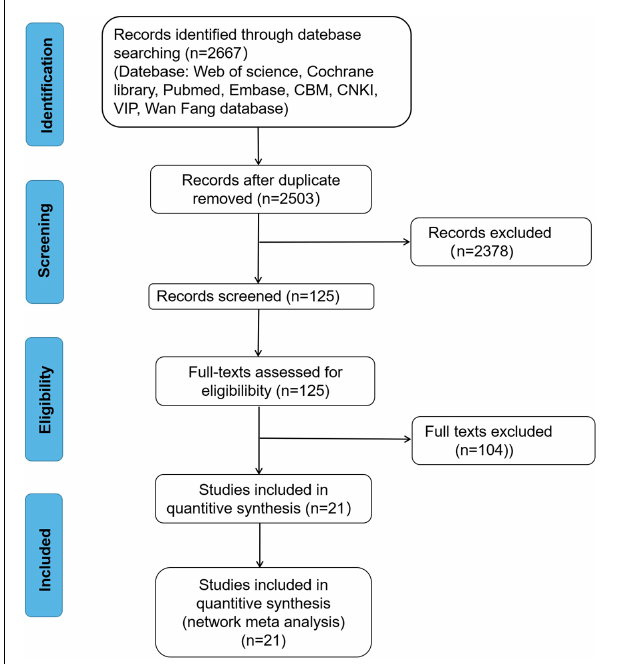
FIGURE 1 | Preferred reporting items for systematic reviews and meta-analysis (PRISMA) flow